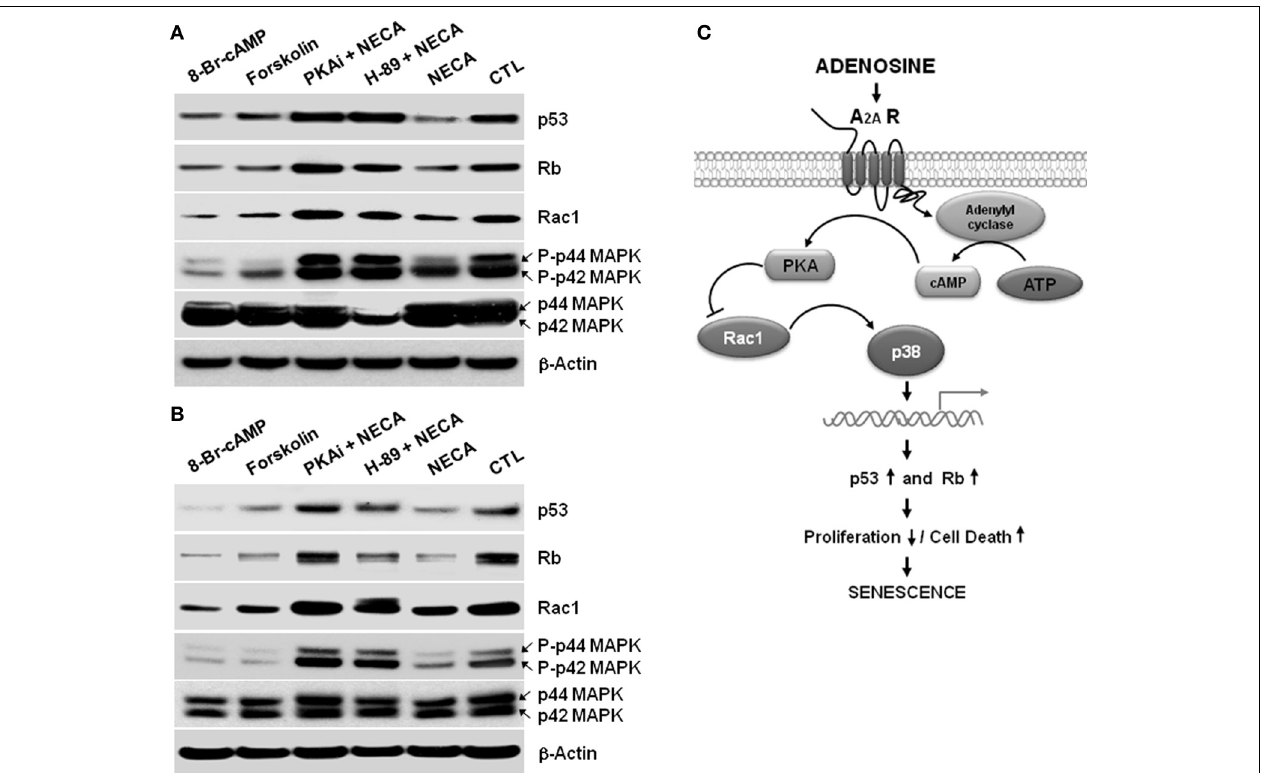
FIGURE 4 | A cAMP analog, or an activator of adenylyl cyclase Forskolin, or NECA down regulates p53 and Rb through down regulation of Rac1 and decreased activation of p38 MAPK in the HSC. LX-2 cells were treated for 2 days, and 10 days cultured activated primary rat HSC were treated for 5 days with 8-Bromo-cAMP (1mM) or, Forskolin (50 μ M) or NECA (10 μ M) in presence or absence of PKA